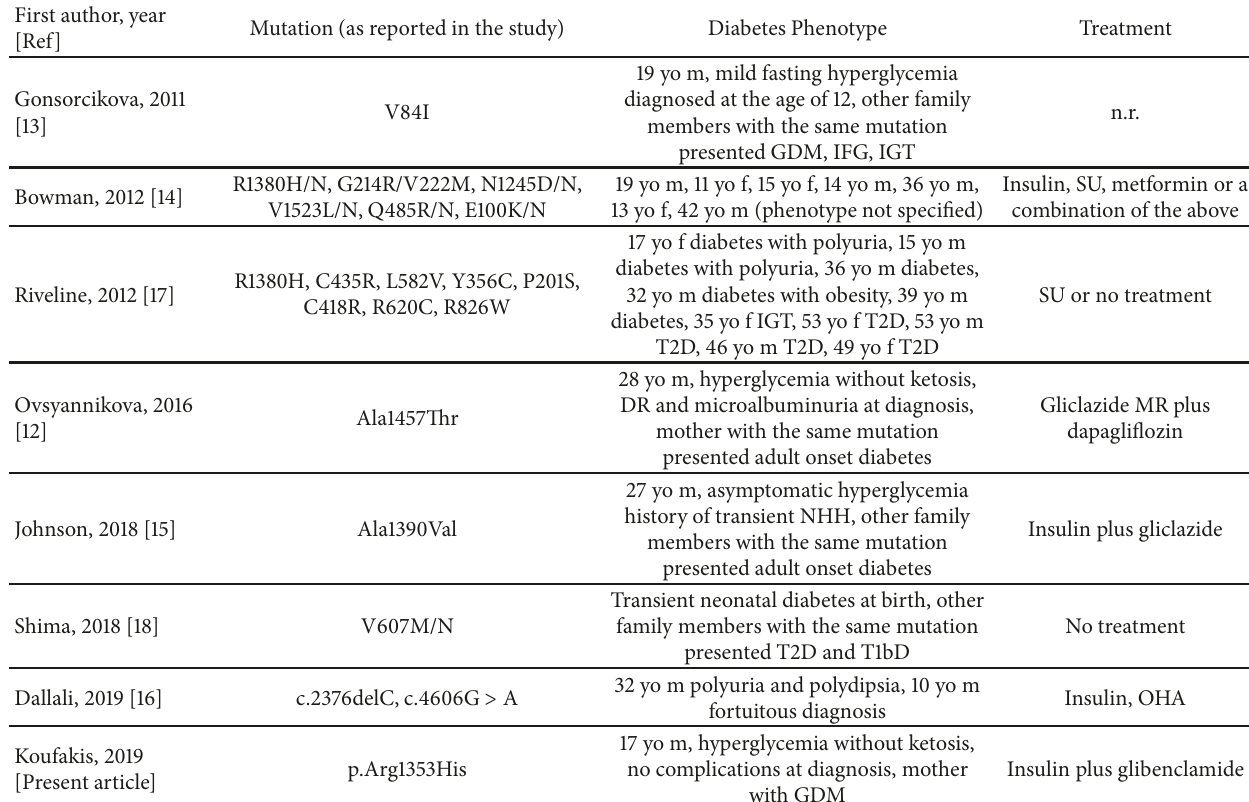
Table 1: Main findings of key studies that reported the presence of mutations in the ABCC8 gene in people with diabetes. Remarkable heterogeneity in terms of both clinical presentation and treatment is